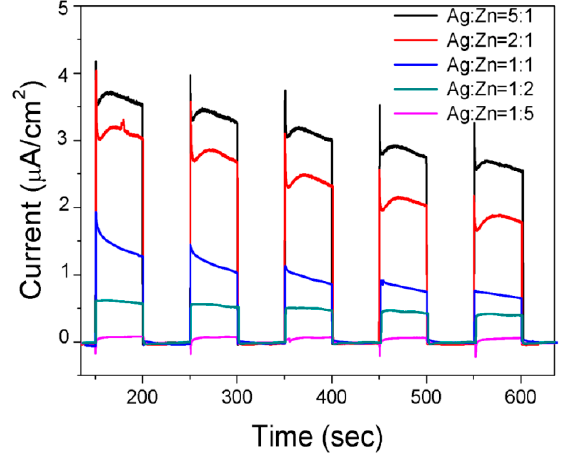
Figure 4. Photocurrent-density responses (I-t) of the samples synthesized with different ratios of Ag:Zn in 0.5 M Na 2 SO 3 solution under simulated sunlight illumination.